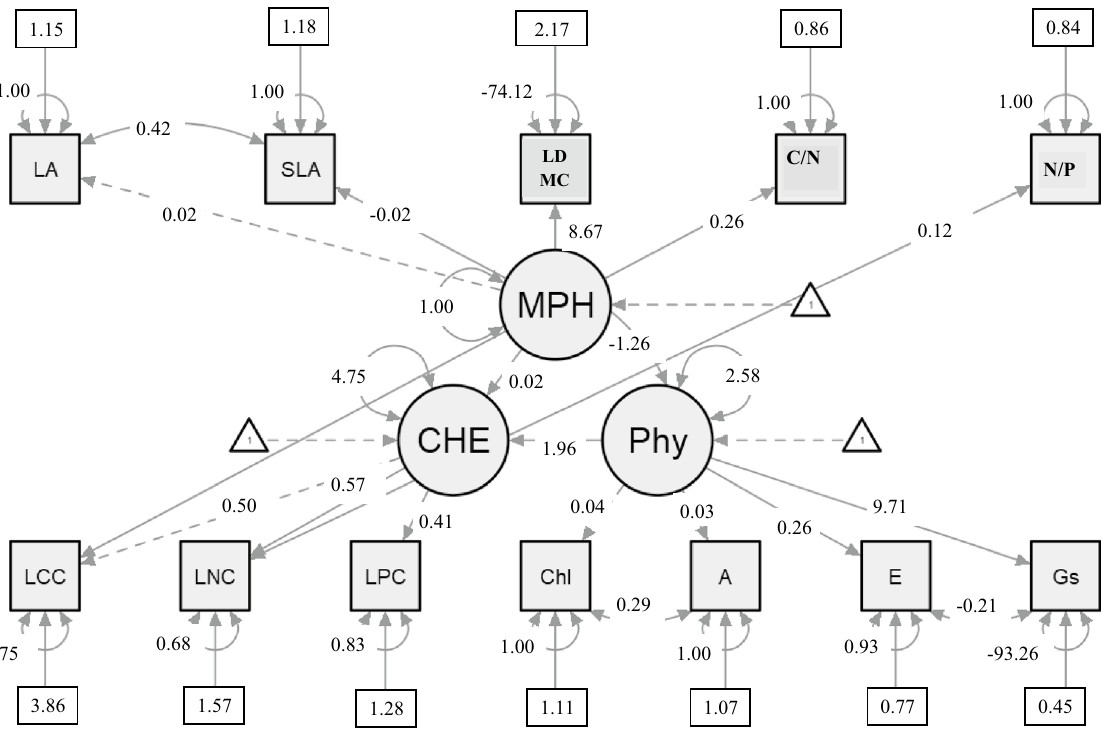
Figure 2. Structural Equation Modeling (SEM) with JASP (Jeffreys’s Amazing Statistics Program) software (A free and Open Lience) “SEM package” (JASP 0.14.1) were used for evaluation of causal relationship among leaf morphological, physiological, chemical and stoichiometry traits in the temperate forest ecosystem. Square nodes indicate manifest variables, circular nodes indicate latent variables, and triangular nodes indicate constant variables (intercepts). Directed edges (single-headed) indicate one variable having an effect on another variable i.e. linear regression parameters and bidirectional edges indicate (co)variances (correlation “r”) between two variables, and the circular curved arrows represent the variance of a variable. The path coefficients represent standardized partial regression coefficients. Dashed line indicates weak relationship, thicker line strong relationship and numbers in brackets are regression coefficients. Morphological; LA = leaf area, cm 2